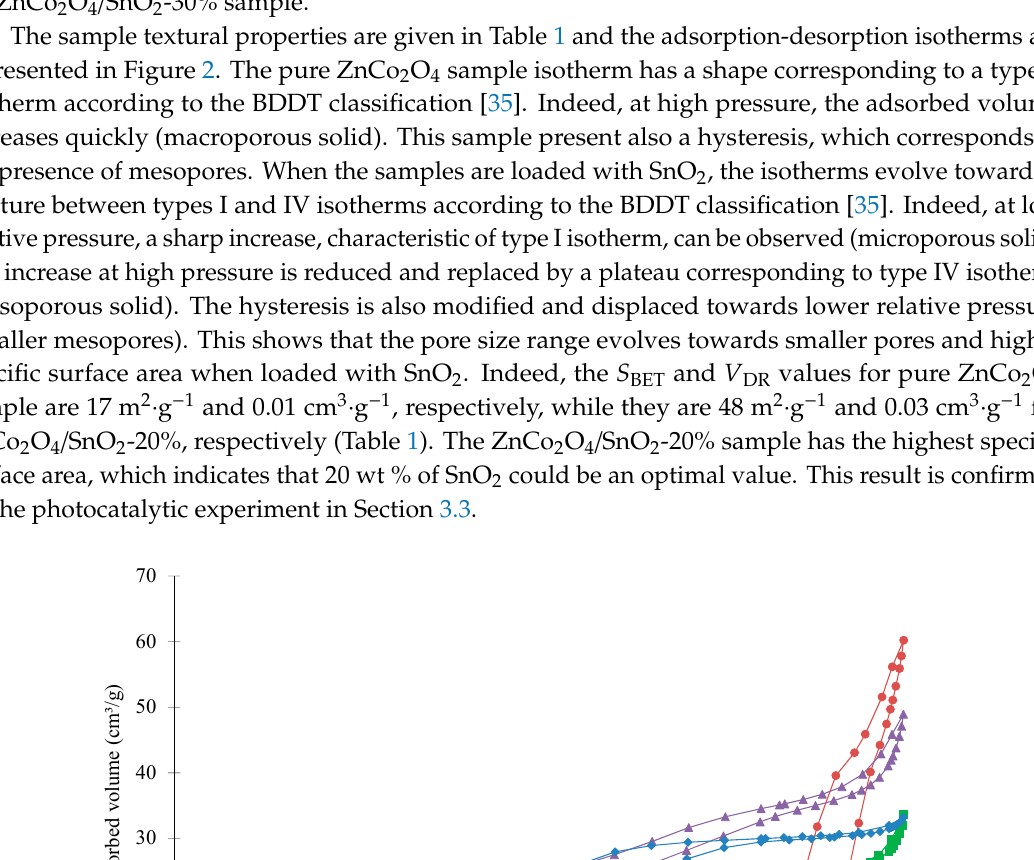
Figure 1. X-ray di ff raction (XRD) pa tt erns of samples: ( ● ) Pure ZnCo 2 O 4 , ( ■ ) ZnCo 2 O 4 /SnO 2 -10%, ( ▲ ) ZnCo 2 O 4 /SnO 2 -20% and ( ♦ ) ZnCo 2 O 4 /SnO 2 -30%. (Z) Reference pattern of cubic spinel ZnCo 2 O 4 and (S) reference pattern of tetragonal rutile SnO 2 .